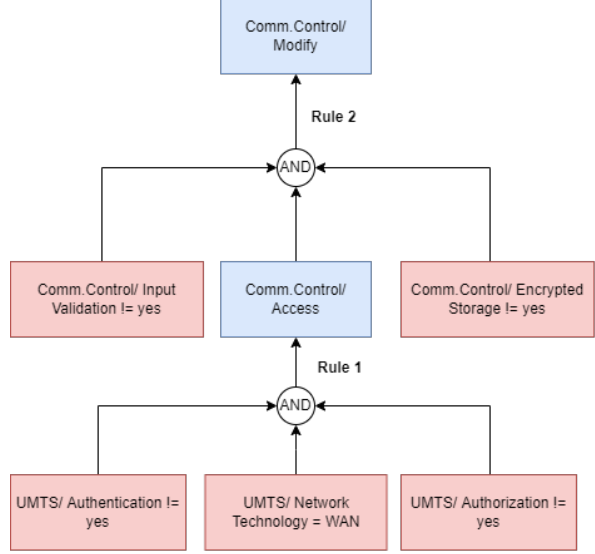
Figure 18. Sub-tree for gaining modification